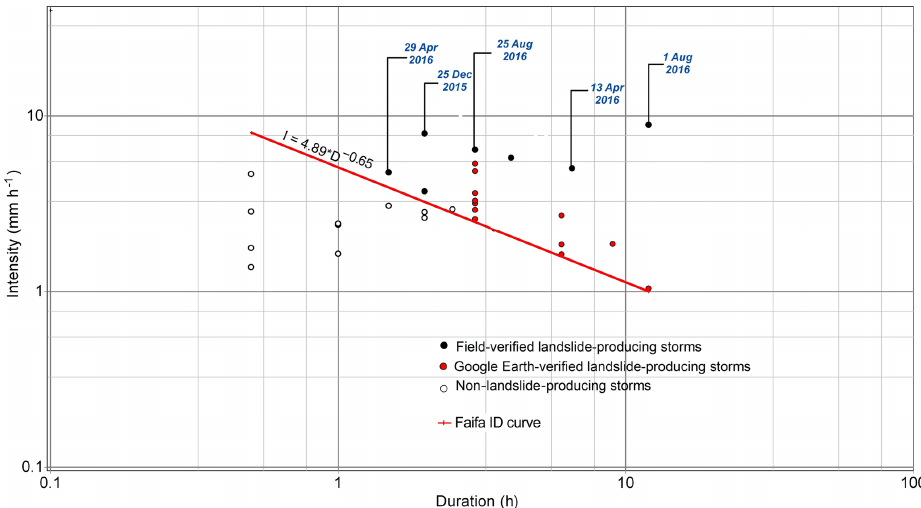
Figure 4. ID scatter plot generated from landslide-producing storm events (solid circles) and non-producing precipitation events (open circles) during the period from 2007 to 2016. The Faifa ID curve (equation: I = 4.89D − 0 . 65 ; duration threshold, x : 0.5 to 12h) separates the landslide-producing events from non-producing